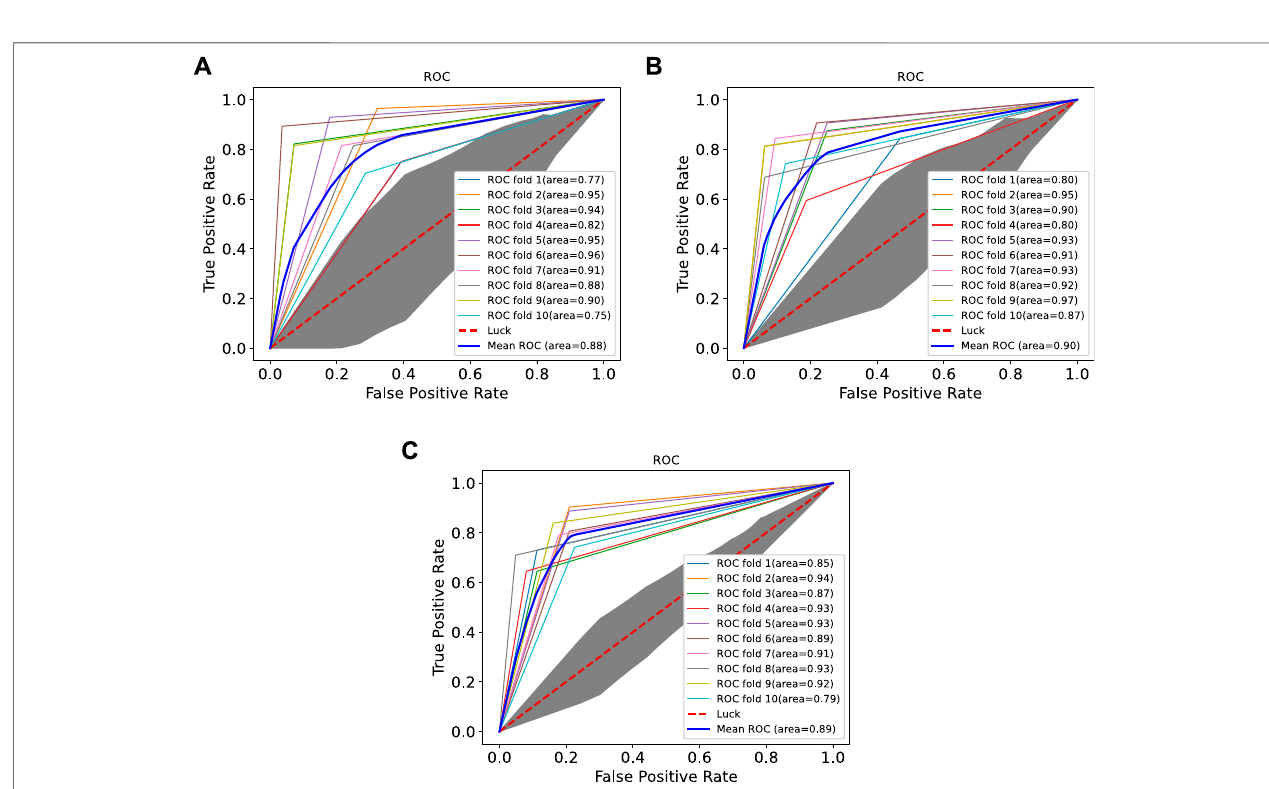
FIGURE 7 | ROC curves on three datasets using RF + LR. ROC, receiver operating characteristic; RF, random forest; LR, logistic regression.